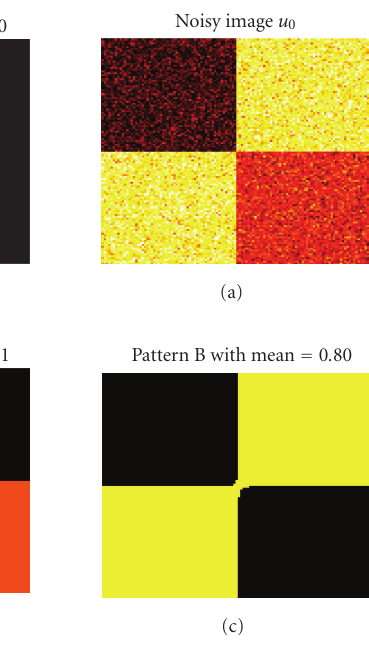
Figure 3: Synthetic image of a T -junction: hard segmentation from the SMS model via “hardening” formulae (5) and (6). The 120- degree regularization behavior at the junction point is also well known in the classical Mumford-Shah model [6].